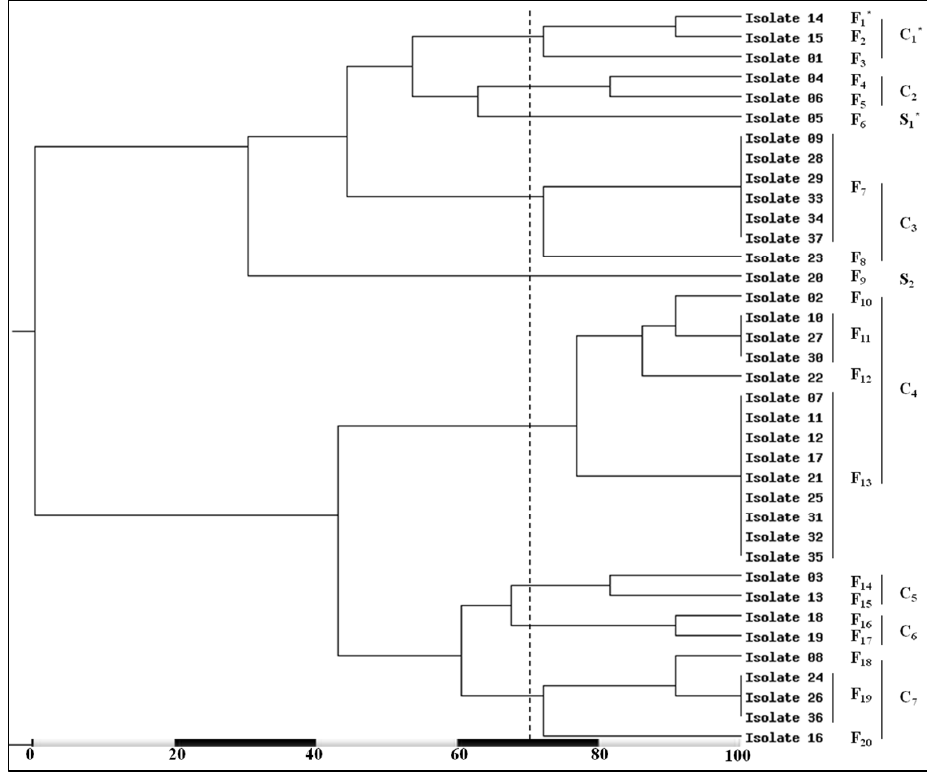
Figure 4. Dendrogram clarifying the variation amongst the tested MRSA isolates on the bases of Alu I enzymatic digestion of coa gene PCR amplicons. * F 1 –F 20 ; the RFLP genotypes, C 1 –C 7 ; the obtained clustered, and S 1 and S 2 ; the established singletons, based on approximately 70% similarity (dotted line).